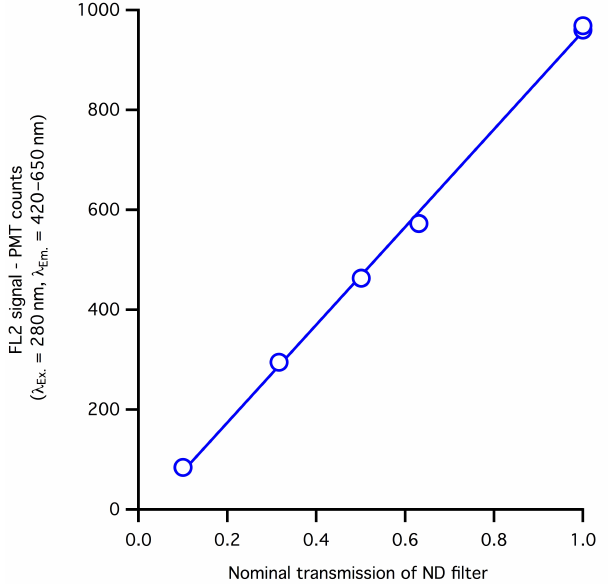
Figure 10. Fluorescence signal magnitudes vs. transmission of xenon flash lamp light. Fluorescence signal magnitudes are the central values of fitted Gaussian functions to histograms of FL2 data from 1µm blue fluorescent PSLs. Nominal transmission values are calculated according to T = 10 − OD , where OD is the nominal manufacturer-quoted optical